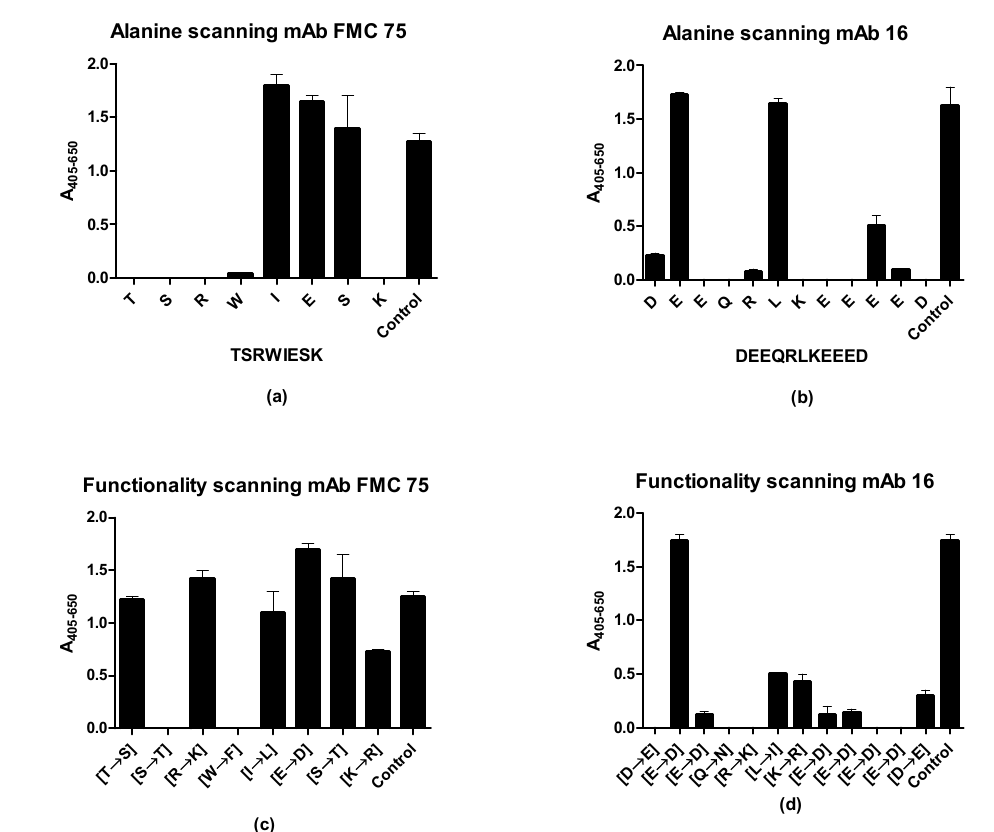
Figure 4. Antibody reactivity to alanine- and functionality-substituted peptides. ( a ) Reactivity of mAb FMC 75 to alanine-substituted peptides. ( b ) Reactivity of mAb 16 to alanine-substituted peptides. ( c ) Reactivity of mAb FMC 75 to functionality-substituted peptides. ( d ) Reactivity of mAb 16 to functionality-substituted peptides.